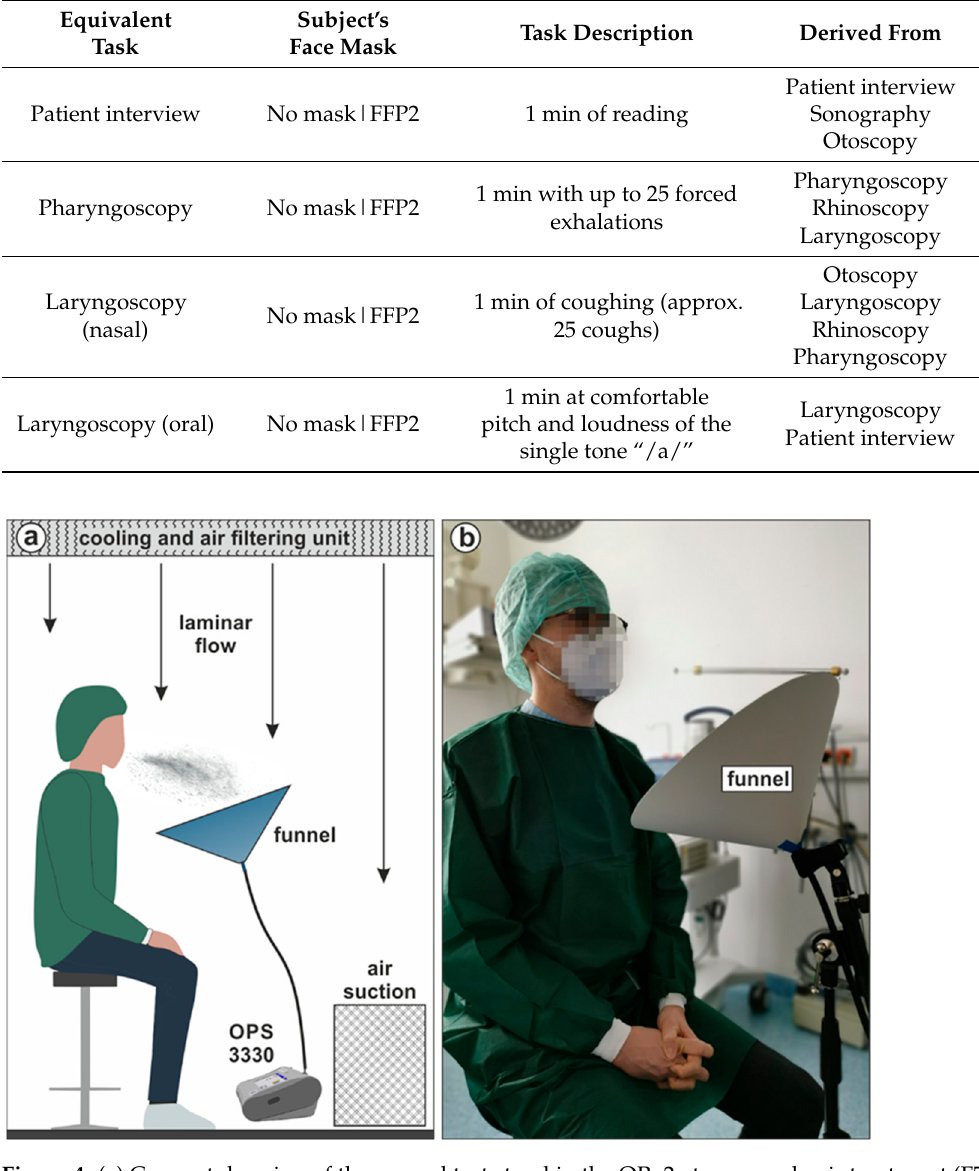
Figure 4. ( a ) Concept drawing of the aerosol test stand in the OR. 2-stage supply air treatment (F7 and F9 filter), temperated air flows laminarly from the ceiling to the floor and is extracted via the air suction unit. Respiratory aerosols expelled by the subject during the procedures are sucked in by the OPS and counted ( b ) Photography of a subject in front of the inlet measuring funnel.